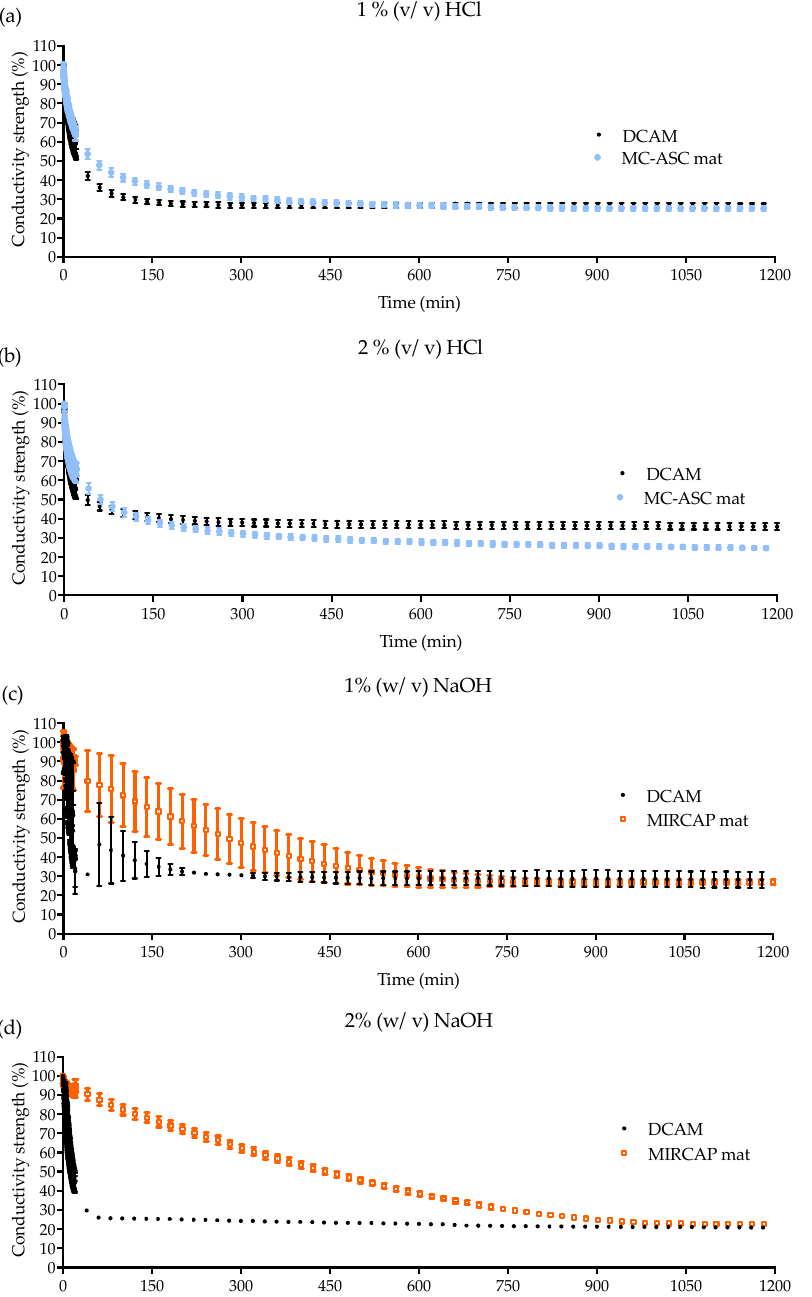
Figure 5. SEM image of MC ‐ ASC deposited inside the mat. The histogram inset represents the size distribution of MC ‐ ASC beads. 2.3. Thermal Analysis The differential scanning calorimetry (DSC) and thermogravimetry (TGA) curves of all compounds are shown in Figures 6 and 7. Analyses were performed at a heating rate